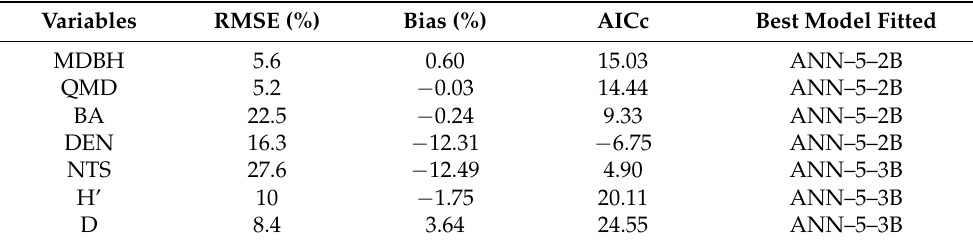
Table 5. Selection of the best model for each estimated forest variable.